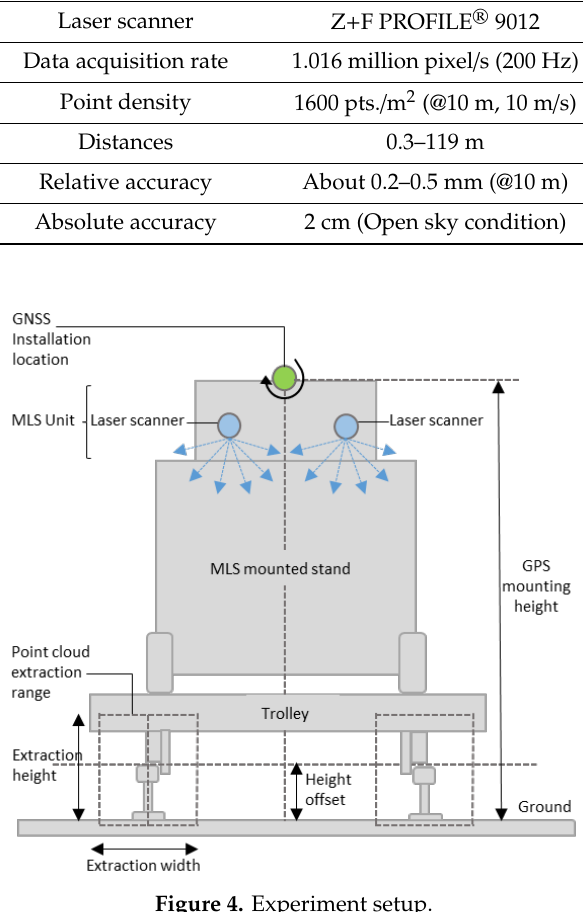
Figure 4. Experiment setup. Table 2. Experiment setup parameters.